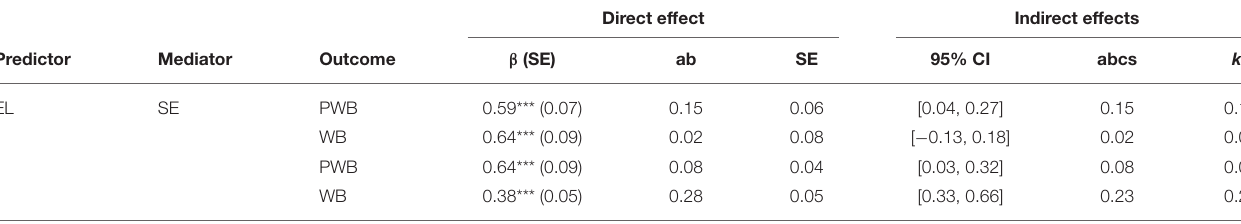
TABLE 4 | Results of bootstrapping tests for estimating indirect effects with 95% confidence intervals